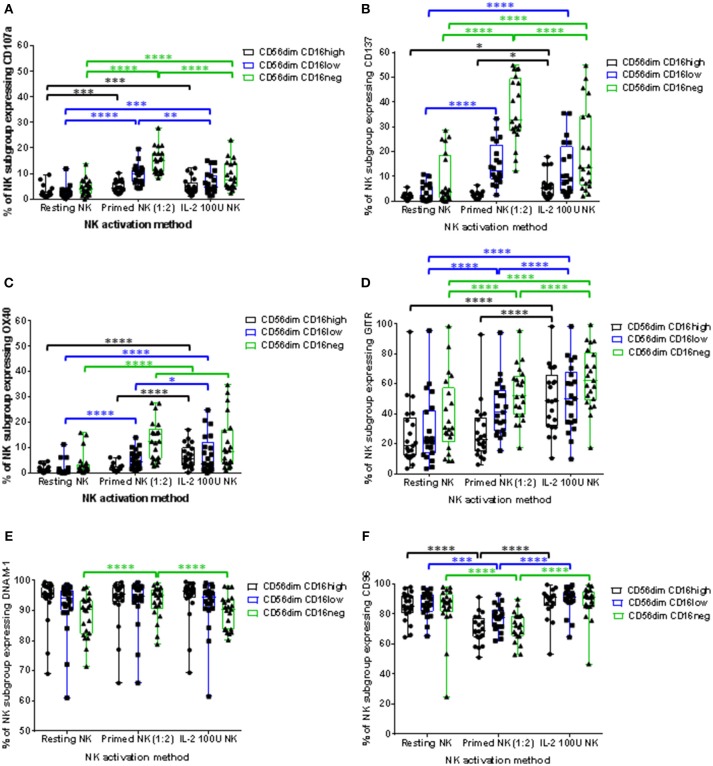
Influence of priming and IL-2 activation on the phenotype of CD56dim NK cell subpopulations. For each patient, isolated NK cells were either primed with mitomycin C treated CTV-1 cells at a 1:2 ratio or activated with 100 IU IL-2, after which the expression of CD107a, CD137, OX40, GITR, DNAM-1, and CD96 by CD56dimCD16high, CD56dimCD16low, CD56dimCD16neg NK subpopulations was measured by flow cytometry and compared to that of resting NK cells. Box and whisker plots show the proportion of each NK cell subpopulation expressing (A) CD107a, (B) CD137, (C) OX40, (D) GITR, (E) DNAM-1, (F) CD96. Statistical analysis was performed using two way ANOVA repeated measure tests combined with Tukey's multiple comparisons test and 95% confidence intervals. * < 0.05, ** < 0.01, *** < 0.001, **** < 0.0001.